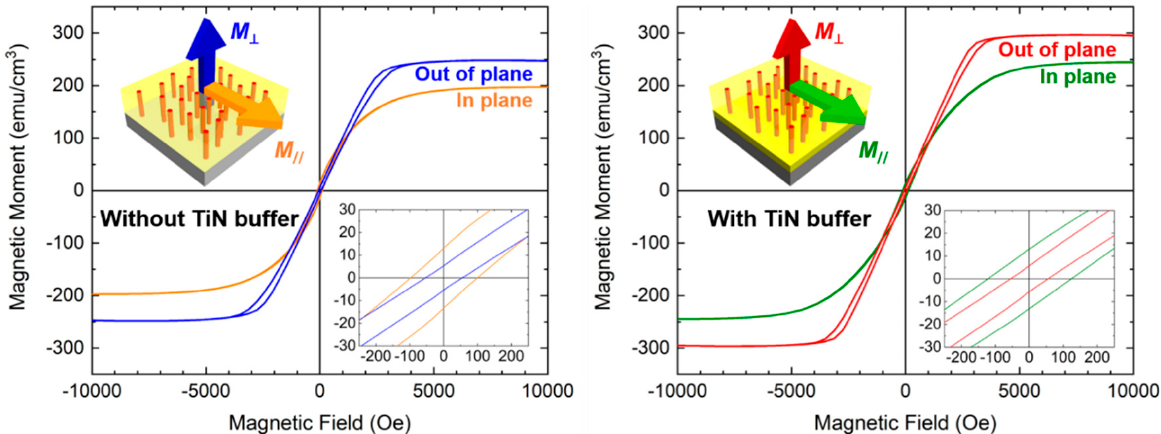
Figure 4. Room temperature in-plane and out-of-plane magnetic hysteresis loops of the TiN–Fe films grown without a TiN buffer ( left ) and with a TiN buffer ( right ).